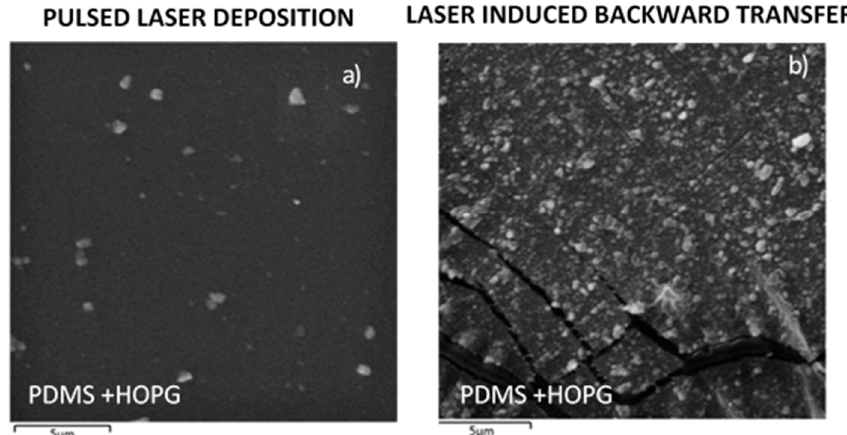
Figure 4. SEM images of PDMS with HOPG deposited by PLD ( a ) and LIBT ( b ).